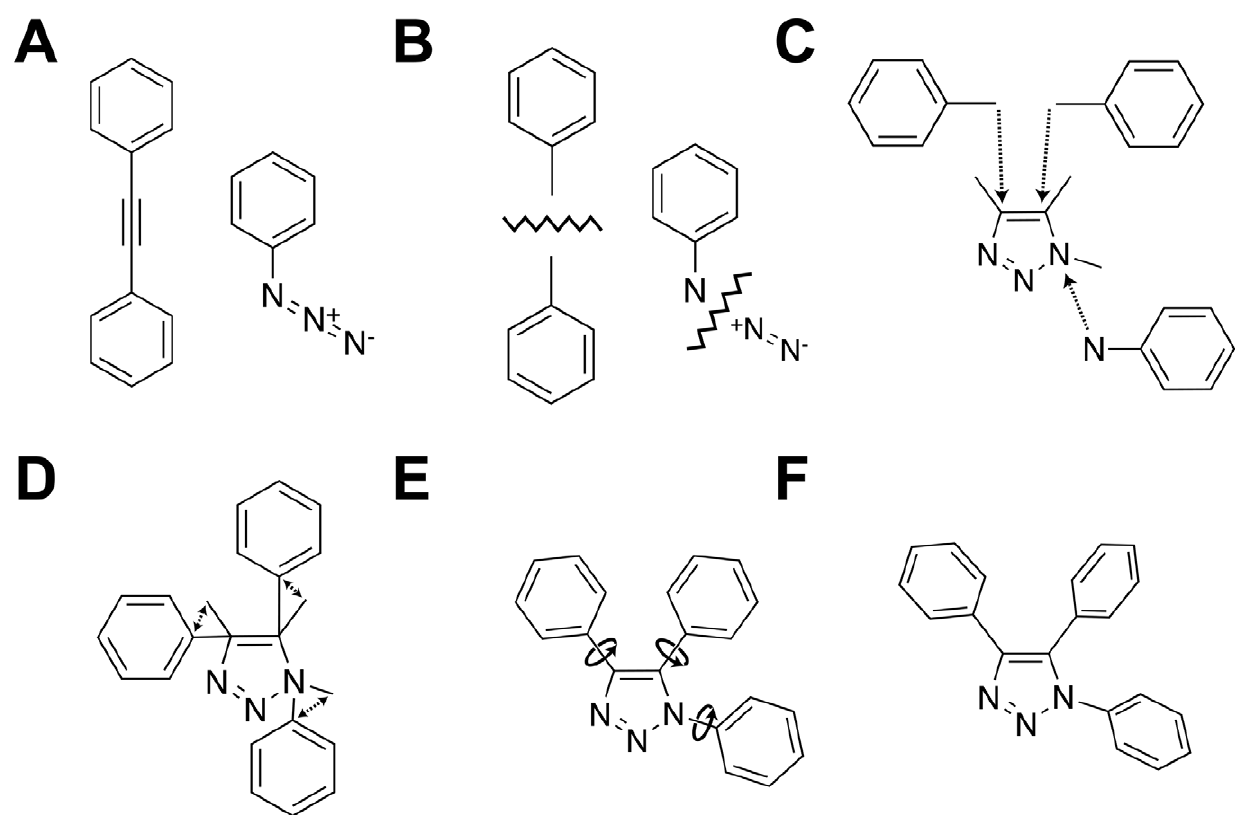
Figure 1. A schematic showing how AutoClickChem mimics the azide-alkyne Huisgen cycloaddition. A) This cycloaddition combines an alkyne and an azide into a 1,2,3-triazole product. B) As a first step, AutoClickChem fragments the alkyne along its triple bond and the azide along the bond connecting its proximal and medial azide nitrogen atom. C) The fragments are then translated so that atomic ‘‘handles’’ are superimposed on top of the corresponding atoms of a 1,2,3-triazole model. D) Next, the fragments are rotated about the handle atoms in order to minimize the distance between the handle-adjacent atoms and the corresponding atoms on the 1,2,3-triazole model. E) The positioned fragments are then rotated in order to reduce steric hindrance. F) Finally, redundant atoms are deleted, and the fragment and 1,2,3-triazole model atoms are merged into a single final structure.